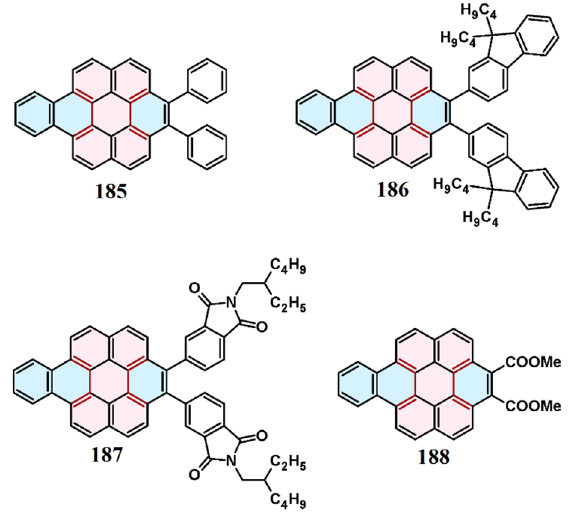
Figure 5. Synthesis of benzocoronenes via the cycloaddition of benzyne to selected 1,2-diarylbenzo[ ghi ]perylenes. Y = 45% ( 185 ); 65% ( 186 ); 78% ( 187 ); and 65% ( 188 ).